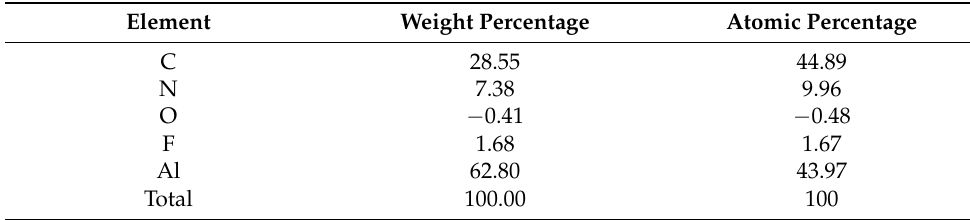
Table 4. Elemental weight and atomic percentage of explosive 2.